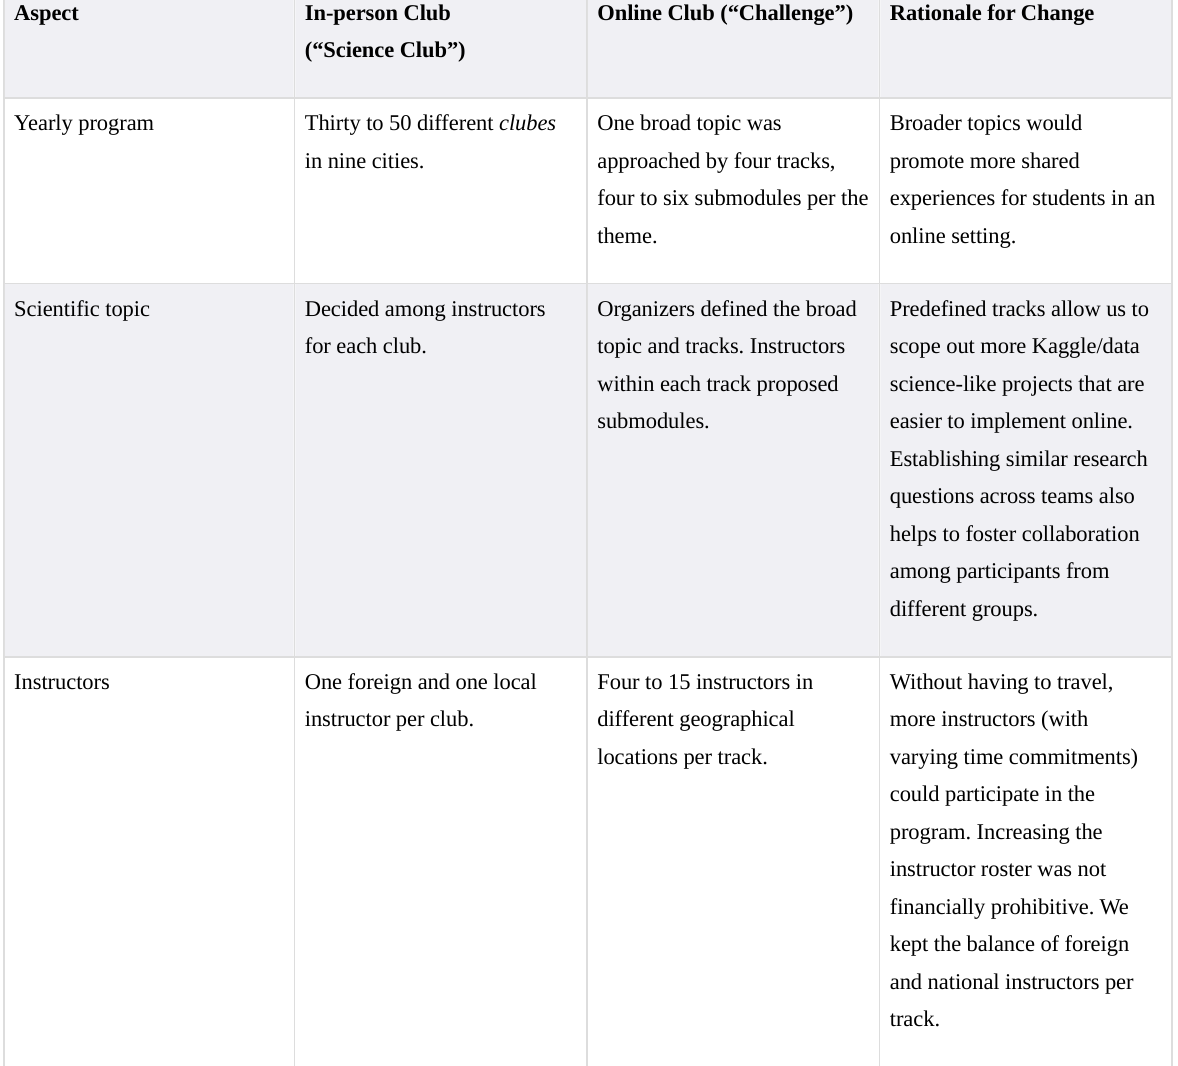
Table 1. Comparison of in-person science club and online challenge implementation.